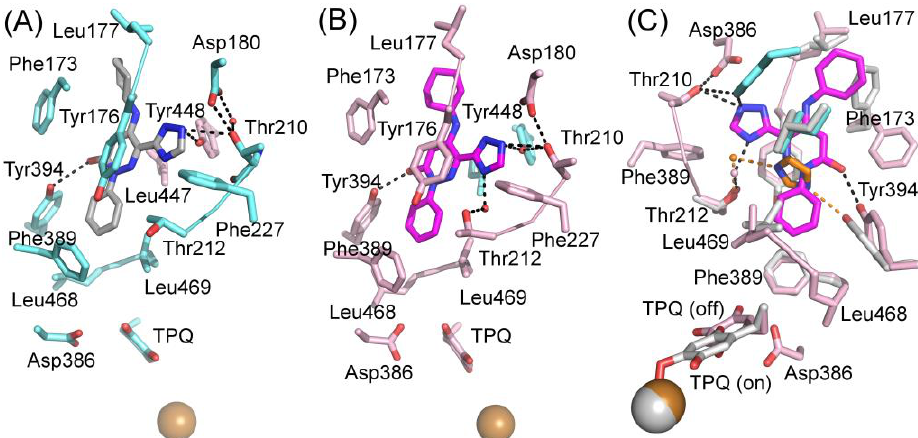
Figure 5. Pyridazinone binding to hVAP-1; ( A ) binding mode of pyridazinone R15 to chain A; ( B ) binding mode of pyridazinone R15 to chain B. Leu447 from the Arm I of chain A (cyan, behind R15) is not labeled; ( C ) comparison of pyridazinone R15 (pink) and the second imidazole (orange) binding to chain B of hVAP-1 (grey). The point of view is rotated to show the hydrogen bonding interactions of R15 (black dashed lines) and imidazole (orange). Labels for Tyr176 (pink), Leu447, and Tyr448 (cyan) stacking with the inhibitors are not shown for clarity.